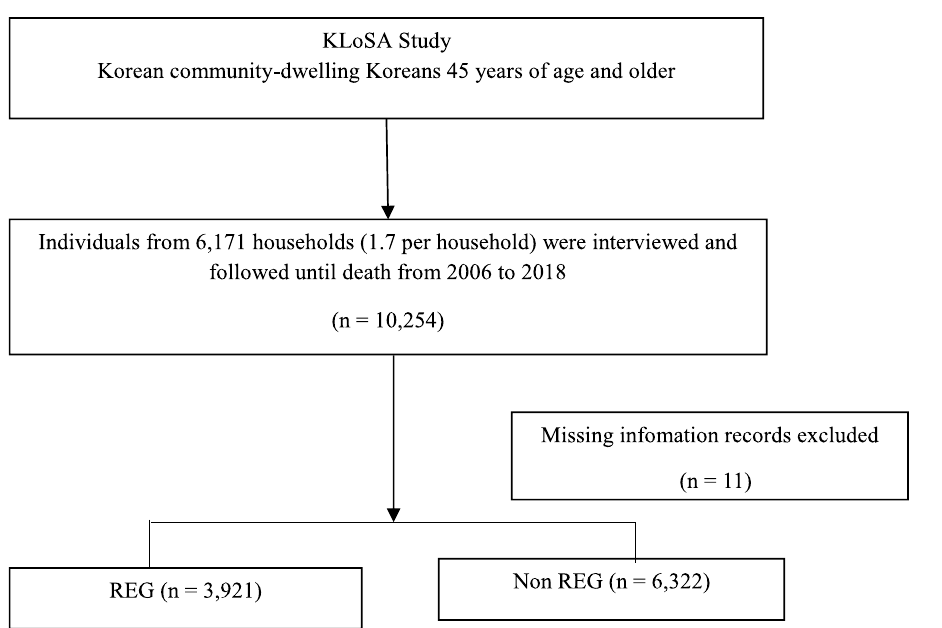
Figure 1. Flow chart of participants included in this